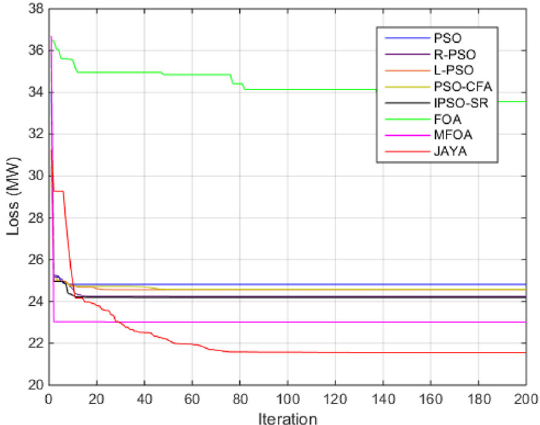
Fig. 4 Convergence characteristics of the algorithms for the IEEE 57 bus system without DG injection